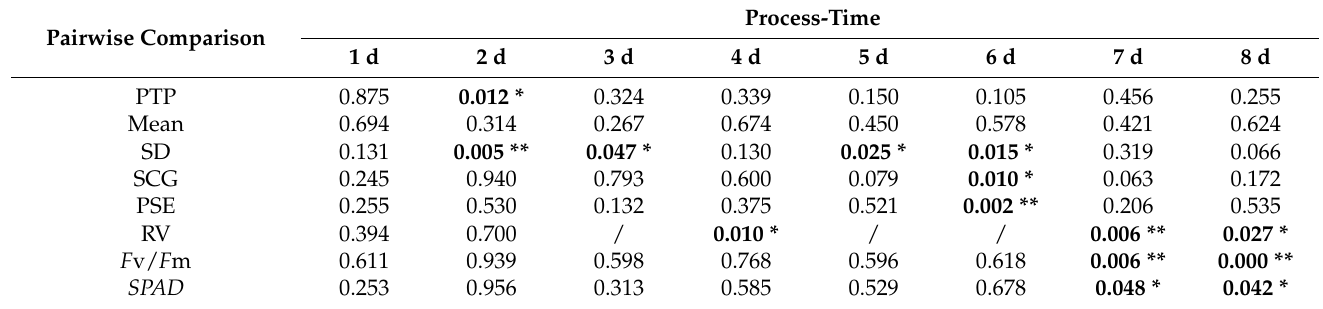
Table 1. The statistics of significant differences of each parameter between the drought treatment and the control treatment during the experiment (Day 1–Day